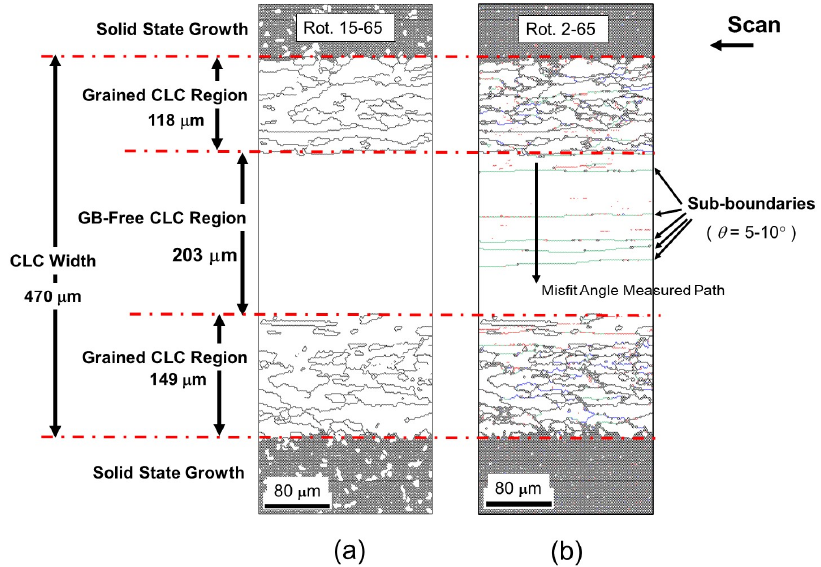
Figure 2. Crystallographic boundaries of the CLC stripe at a laser power close to the threshold of lateral grain growth. ( a ) Grain boundaries (15° < θ < 65°); ( b ) sub-boundaries ( − : 2° < θ < 5°, − : 5° < θ < 10°, and − : 10° < θ < 15°) and grain boundaries ( − : 15° < θ < 65°). The path along which the misfit angle was measured is indicated by an arrow.